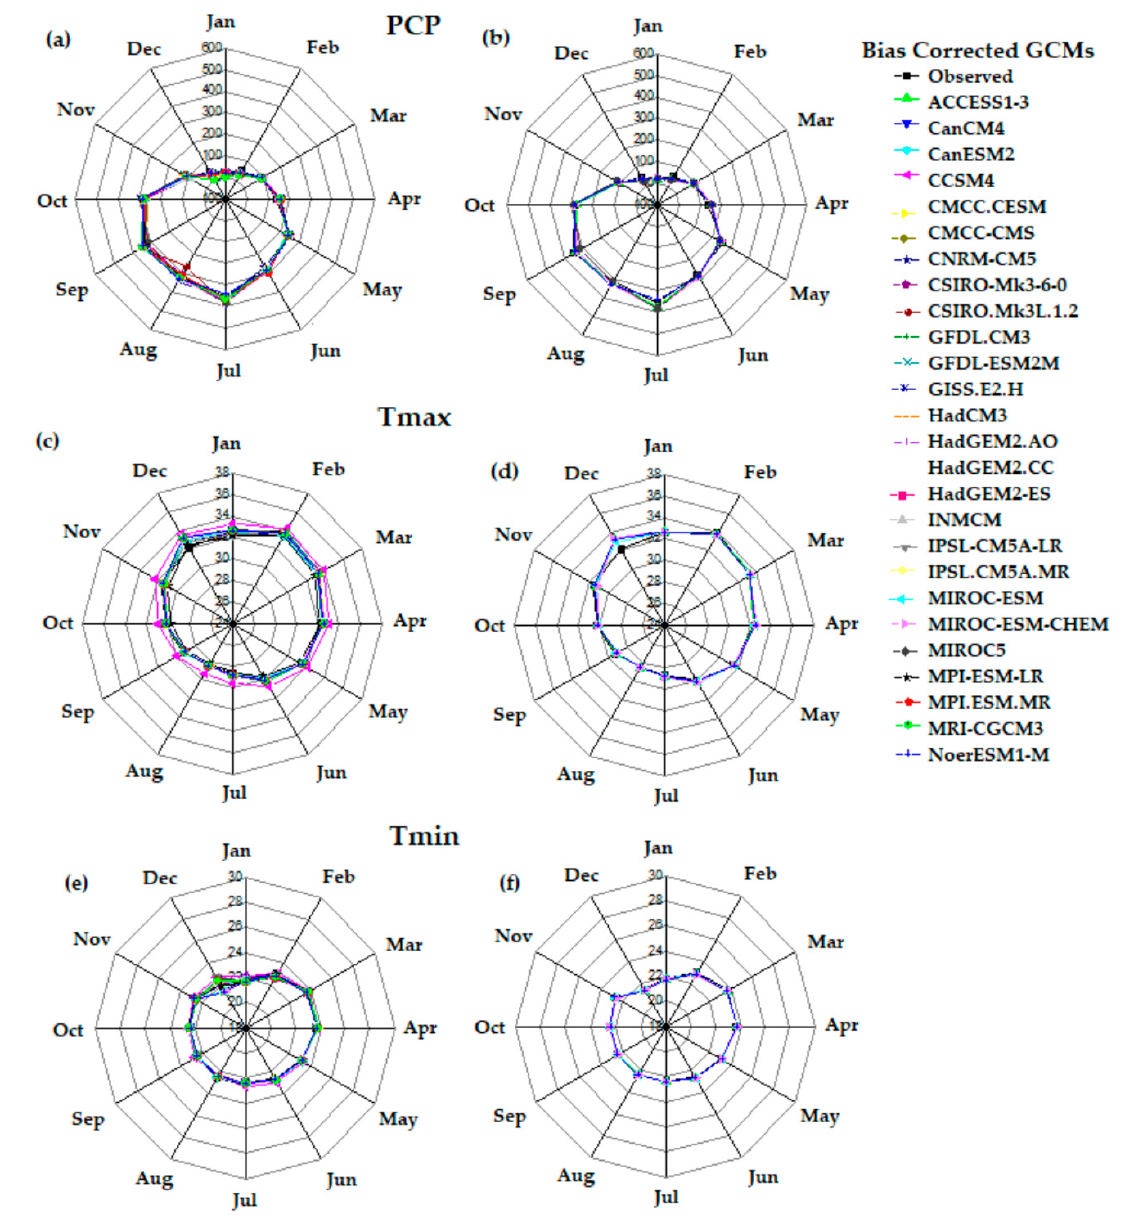
Figure 4. Monthly averages of CRU and bias corrected datasets. ( a ) 26 Prcp, ( b ) 4 Prcp SU, ( c ) 26 Tmax, ( d ) 4 Tmax SU, ( e ) 26 Tmin, and ( f ) 4 Tmin SU GCM outputs for the historical period 1980–2005 at the grid point located in Port Harcourt.